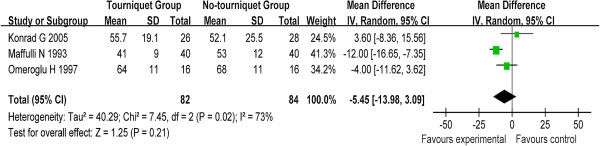
Meta-analysis of patients’ operation time in the tourniquet and non-tourniquet groups.